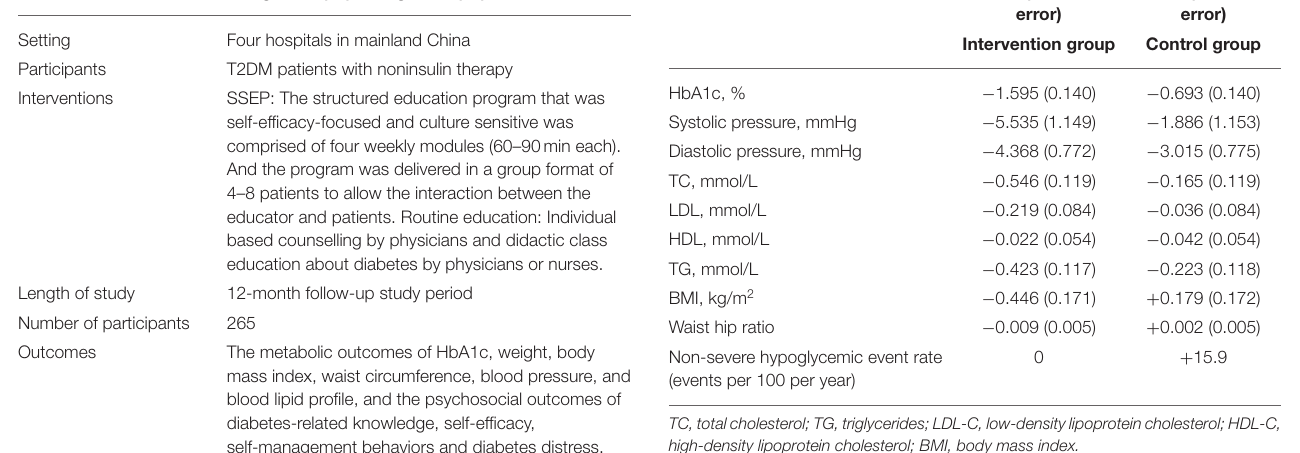
TABLE 1 | Overview of the trial. Jiang et al. (19); Jiang et al. (20)